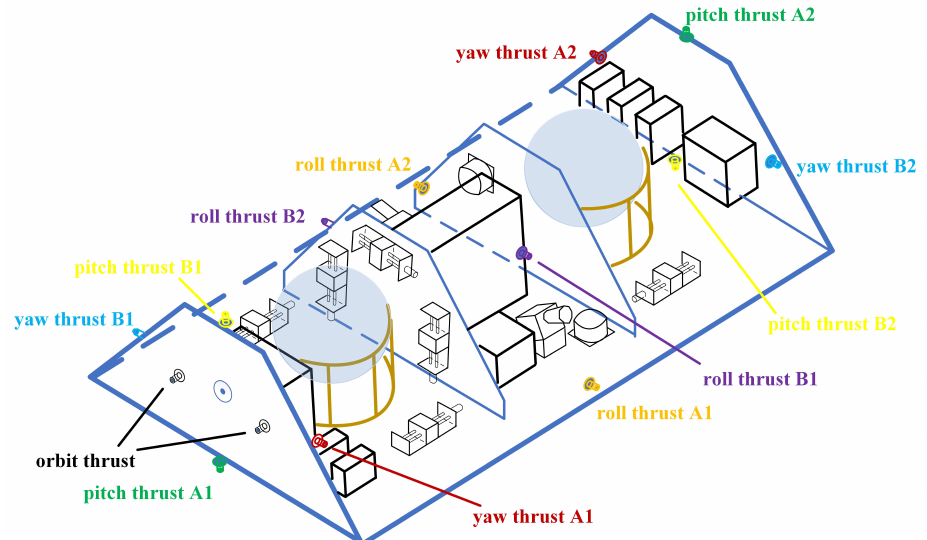
Figure 16. Illustration of cold-gas thrusters arrangement in body